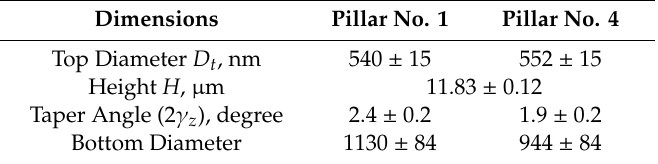
Table 1. Geometrical dimensions of the tapered silicon pillars determined by SEM.